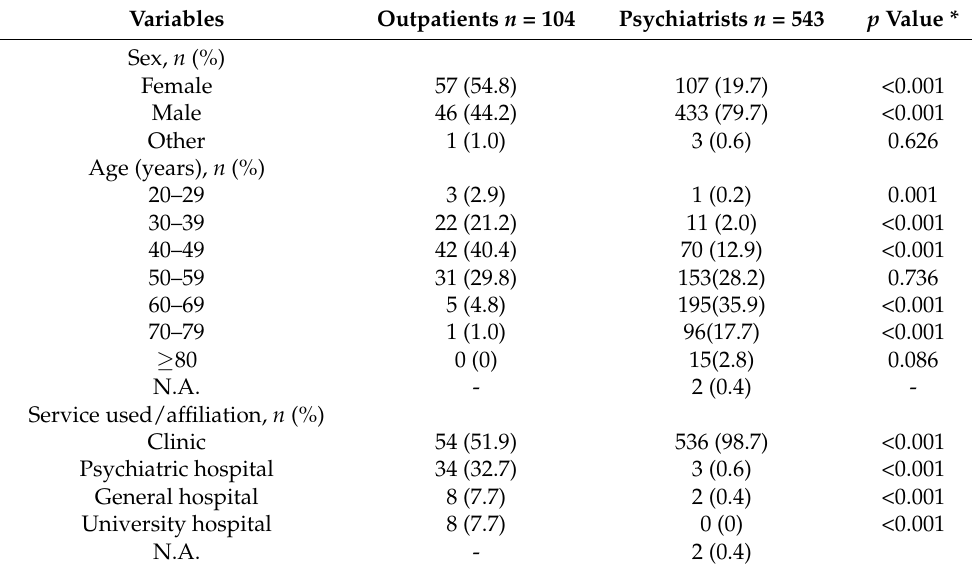
Table 1. Demographic details and other characteristics of the